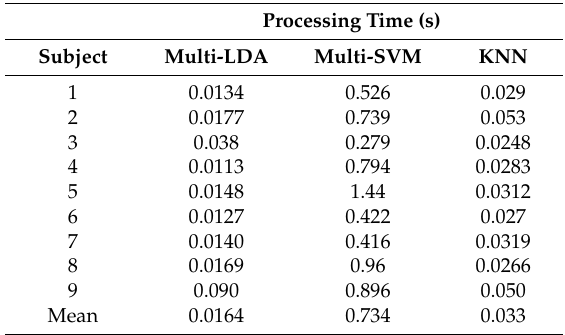
Table 5. Processing time for multi-LDA, multi-SVM and KNN during the training phase.